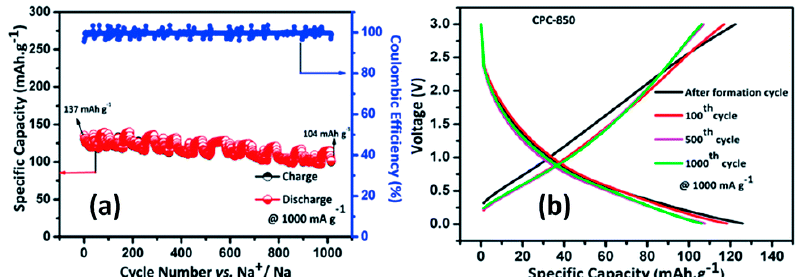
Figure 8. ( a ) Charge-discharge behavior of coir pith derived carbon prepared at 850 ◦ C (CPC-850) as an anode at 1000 mA · g − 1 . ( b ) Voltage vs. capacity behavior CPC-850 anode upon progressive cycles after formation cycle. Reproduced with permission from [217]. Copyright 2017 Royal Society of Chemistry.